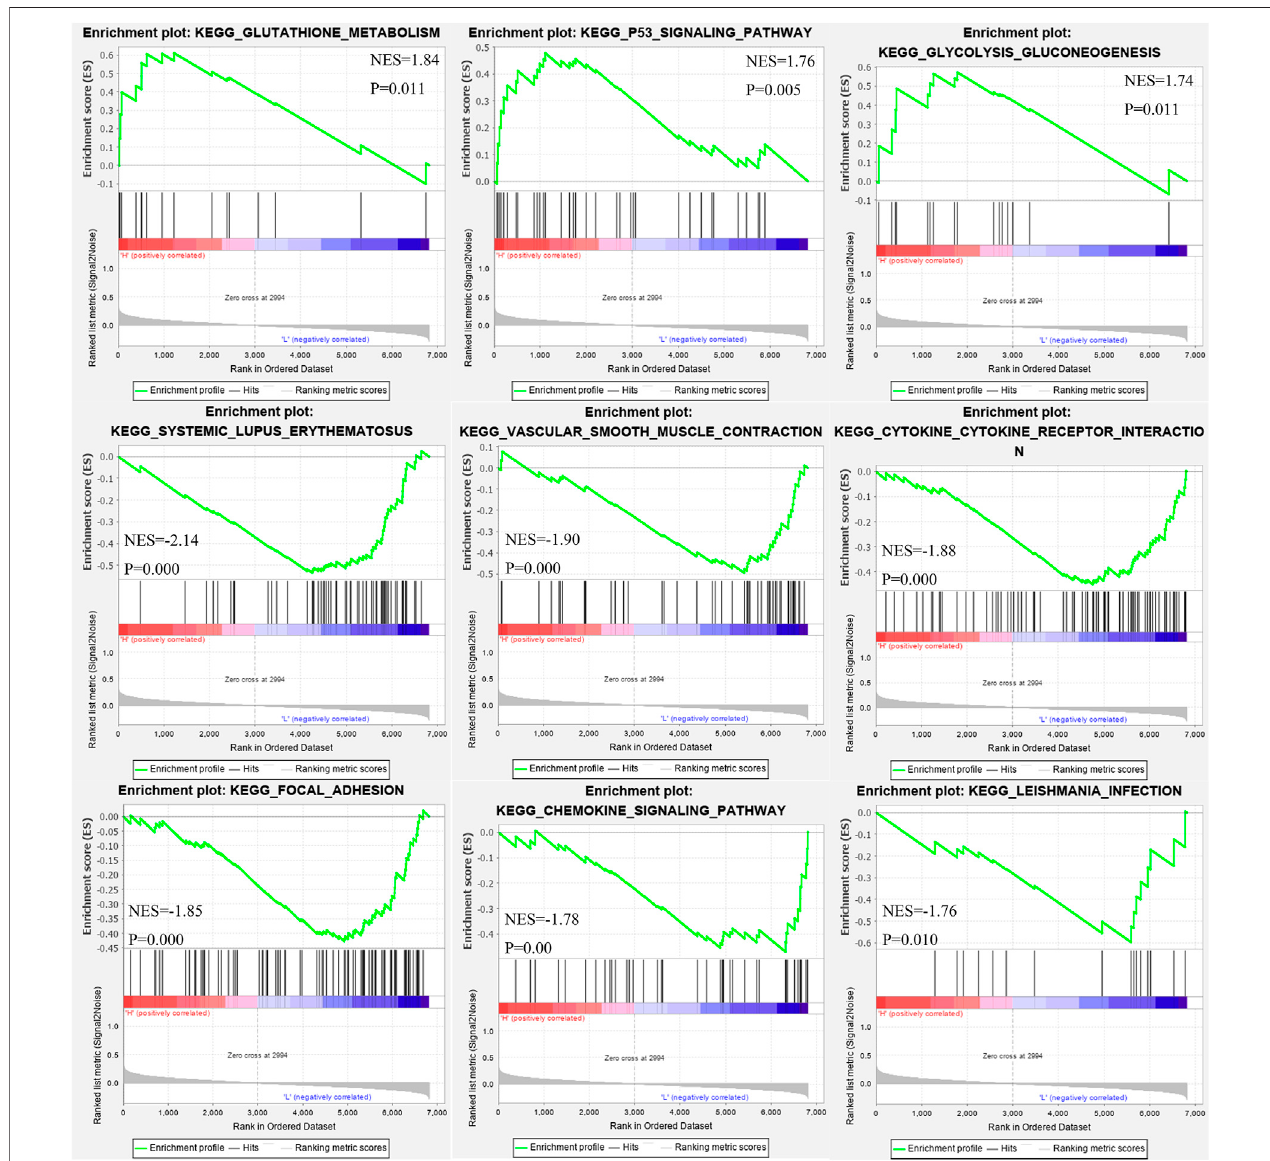
FIGURE 9 | Enrichment plots from gene set enrichment analysis (GSEA) show differential enrichment of genes in KEGG with high MSMO1 expression.